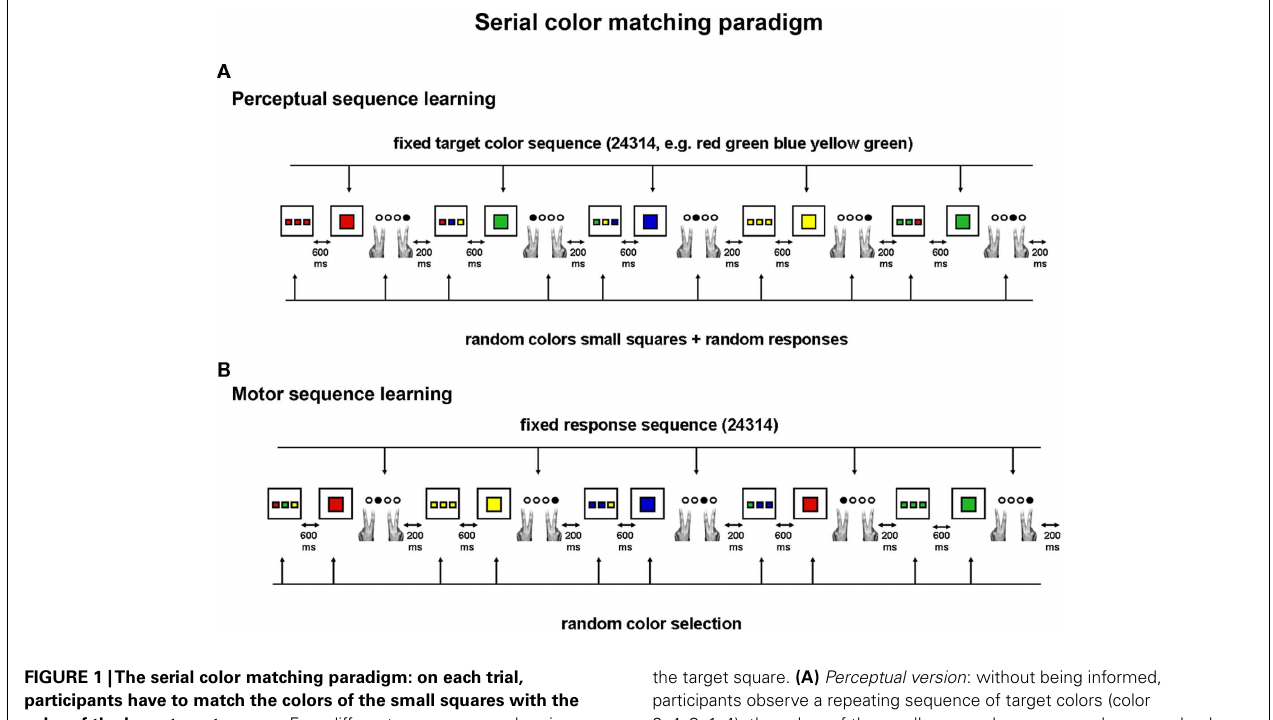
FIGURE 1 |The serial color matching paradigm: on each trial, participants have to match the colors of the small squares with the color of the large target square. Four different responses can be given: response 1 corresponds to the condition where none of the colors of the small squares match the color of the target square; response 2 to the condition where one color of the small squares match the color of the target square; response 3 to the condition where two colors of the small squares match the color of the target square and response 4 to the condition where all three colors of the small squares match the color of